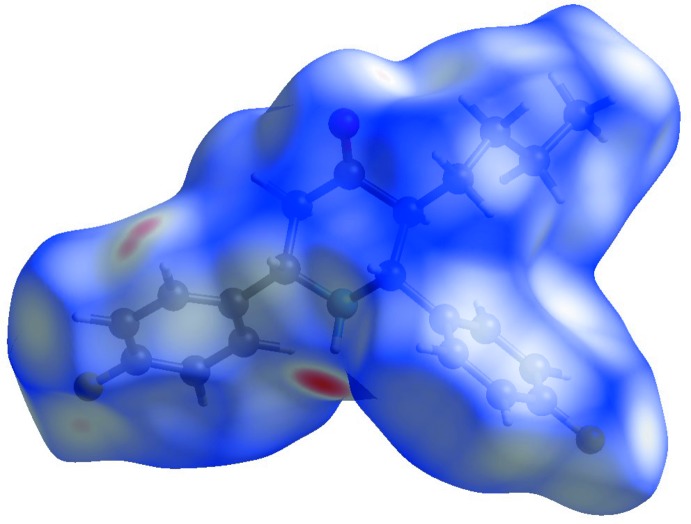
A view of the three-dimensional Hirshfeld surface for C21H23F2NO, plotted over d
norm in the range −0.39 to 1.31 a.u.